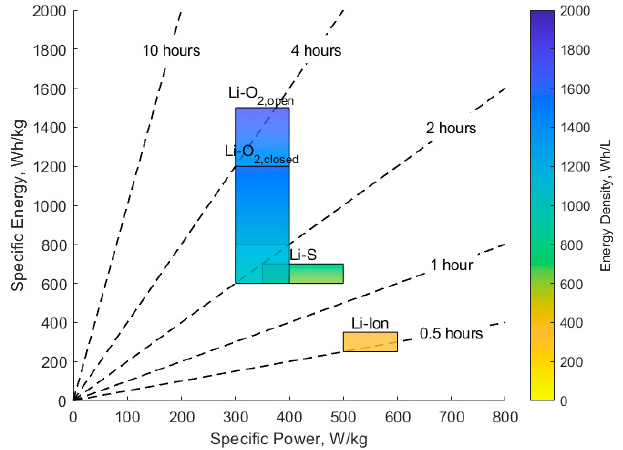
Figure 12. Ragone plot (in linear scales) of the forecasted battery cells technology by 2035.